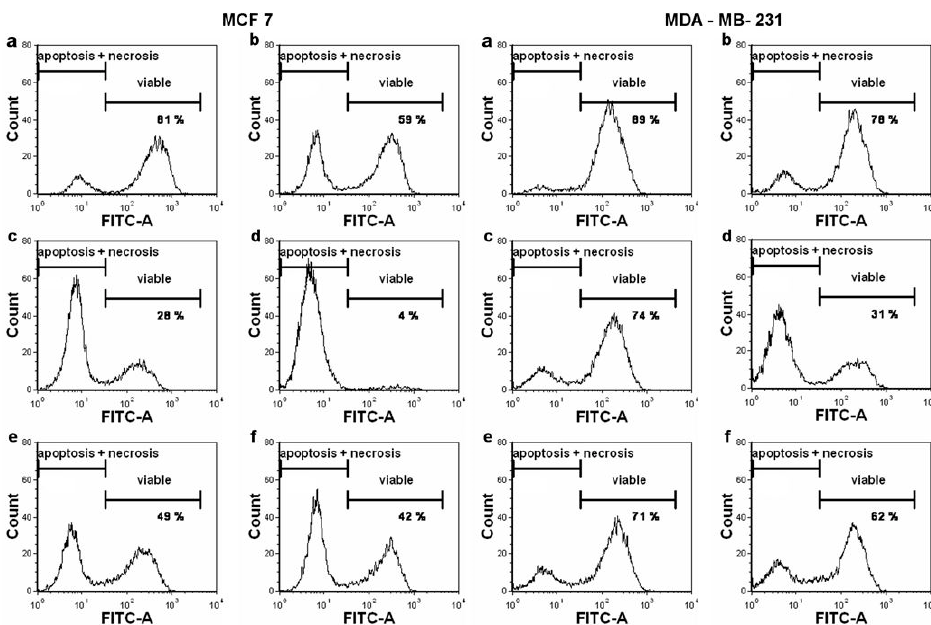
Figure 4. Apoptosis and necrosis induction by triorganotin isothiocyanate derivatives in MCF 7 and MDA-MB-231 cells measured by flow cytometry (FDA/PI staining). The proportion of viable (FDA+/PI-), apoptotic (FDA-/PI-), and necrotic (FDA-/PI+) cells is illustrated in histograms after following treatment: ( a ) control, ( b ) Taxol 1 μ M (positive control), ( c ) TBT-ITC 500 nM, ( d ) TBT-ITC 1 μ M, ( e ) TPT-ITC 500 nM, and ( f ) TPT-ITC 1 μ M. The data presented are representative histograms of three independent experiments.